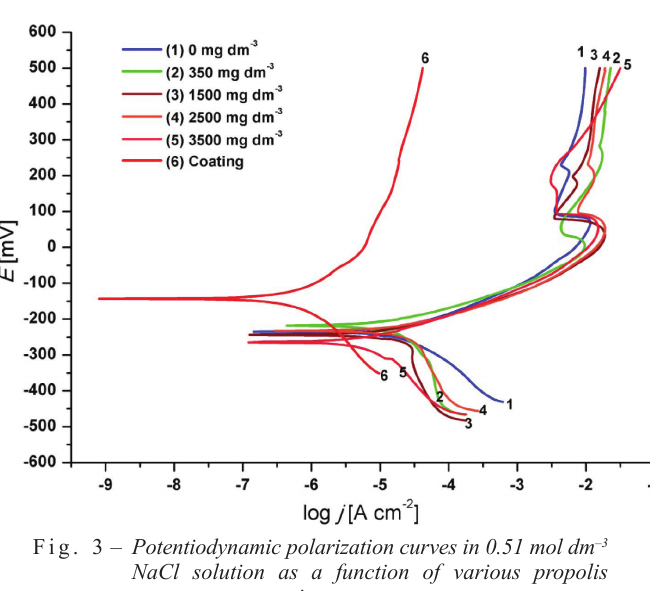
Fig. 3 – Potentiodynamic polarization curves in 0.51 mol dm –3 NaCl solution as a function of various propolis extract concentrations